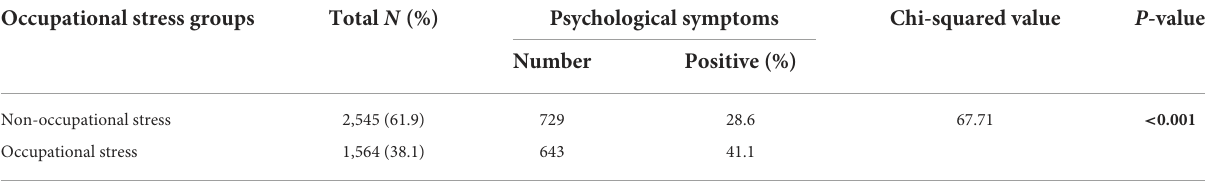
TABLE 4 Comparison of psychological symptoms between different occupational stress